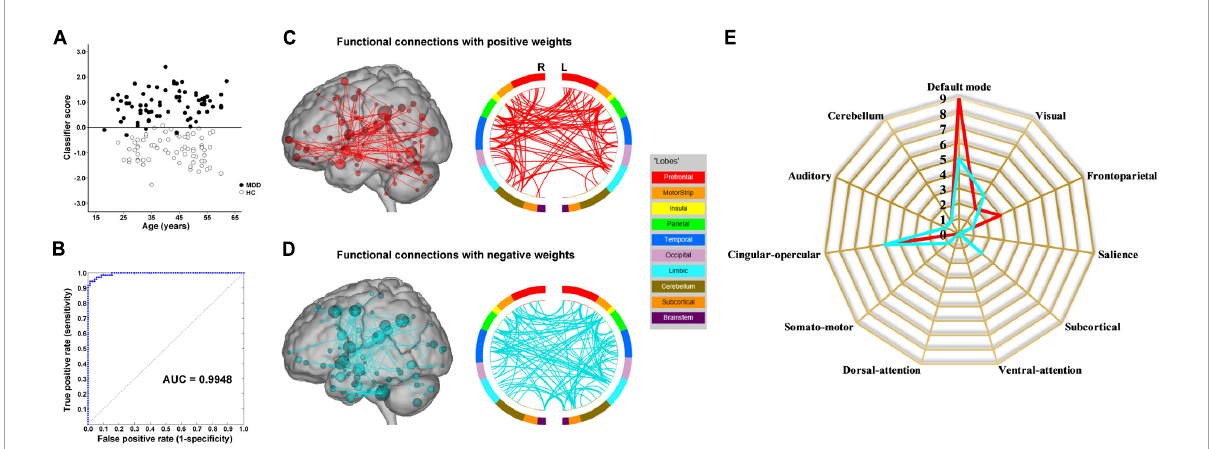
FIGURE5 Static functional connectivity-based classification using fMRI data with global signal regression. (A) Scatter plot showing classification scores of all the subjects. (B) Receiver operating characteristic (ROC) curve of the classifier. (C) High-degree nodes (degree ≥ 8, larger spheres indicate nodes with higher degree) and their connections in the positive network. (D) High-degree nodes (degree ≥ 8) and their connections in the negative network. (E) Fingerprints of the 25 highest-degree nodes summarized by overlap with canonical neural networks.